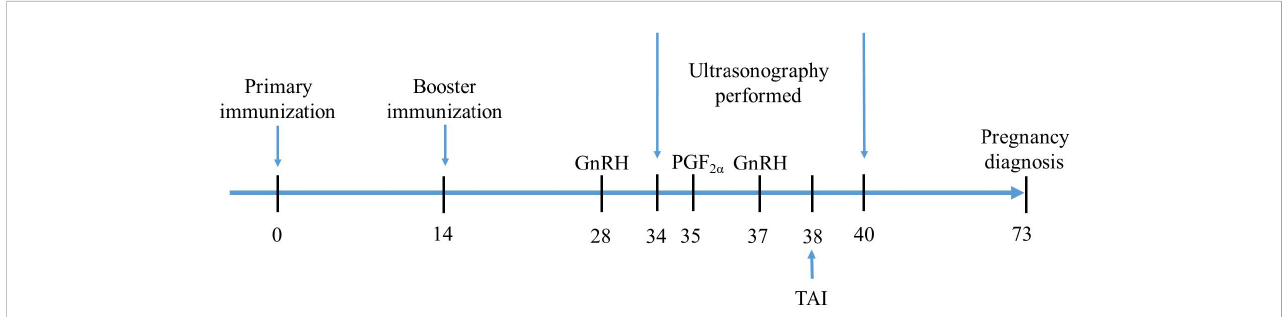
FIGURE 2 An outline of experimental design. Experimental buffaloes were immunized with AMH-INH-RFRP DNA vaccine on days 0 and 14, and control group were administered with PBS. All buffaloes underwent the Ovsynch-TAI program after 2 weeks of booster immunization. Ultrasonography was conducted from day 34 to 40 at 12 h interval to evaluate the folliculogenesis and ovulation. At day 73, pregnancy diagnosis was performed for all